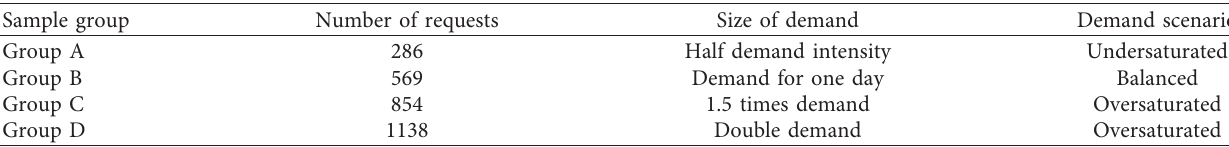
Figure 6: Matching between users and vehicles. (a) Visualization of matching. (b) Visualization of battery utility. Table 2: Description of sample